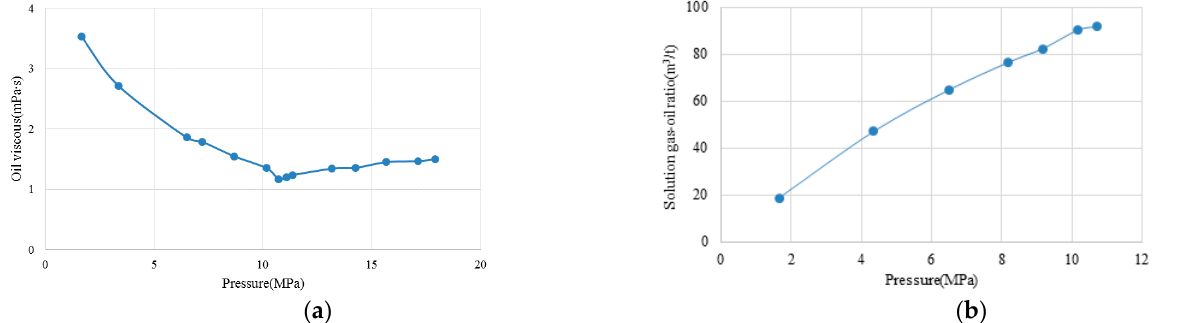
Figure 13. Some of the required physical property parameter conditions: ( a ) crude oil viscosity-pressure; ( b ) solution gas–